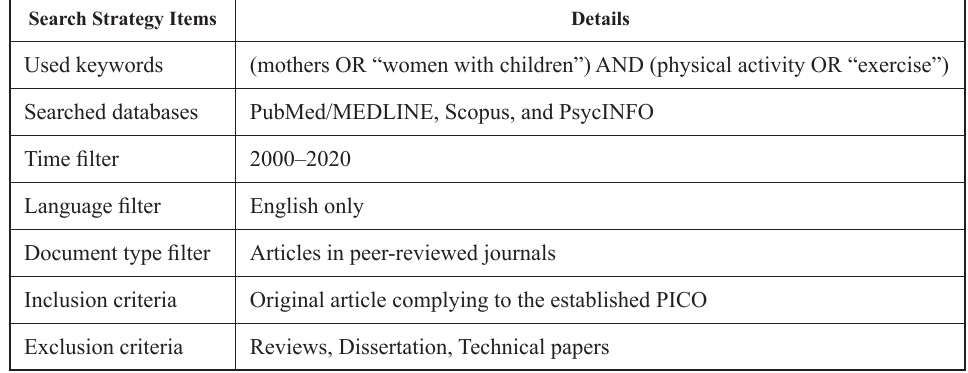
search strategies used in current